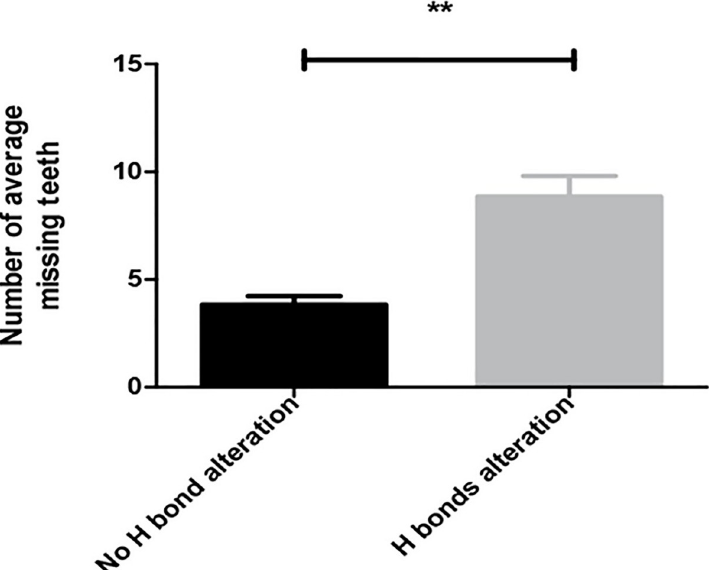
Fig 4. Statistical analysis. Comparison of the average missing teeth number caused by missense mutations in MSX1 homeodomain with and without hydrogen bonds alteration obtained from different non-syndromic tooth agenesis patients (patients caused by missense mutations that had no hydrogen bond alteration, n = 6, vs. patients caused by missense mutations that had hydrogen bonds alteration, n = 19). Data are shown as mean ± SEM. An unpaired t test with two-tailed p -values was performed using GraphPad Prism 5 software. P value = 0.0086 obtained by analyzing data. �� denotes a P -value <